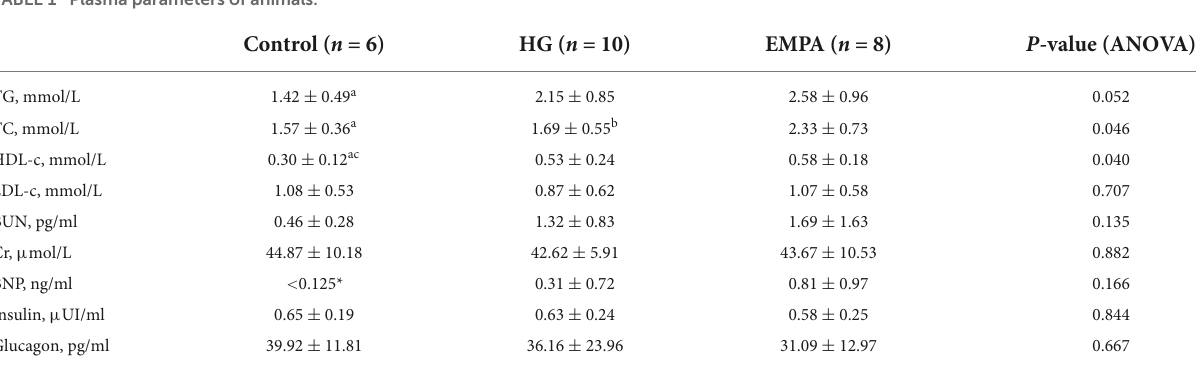
TABLE 1 Plasma parameters of